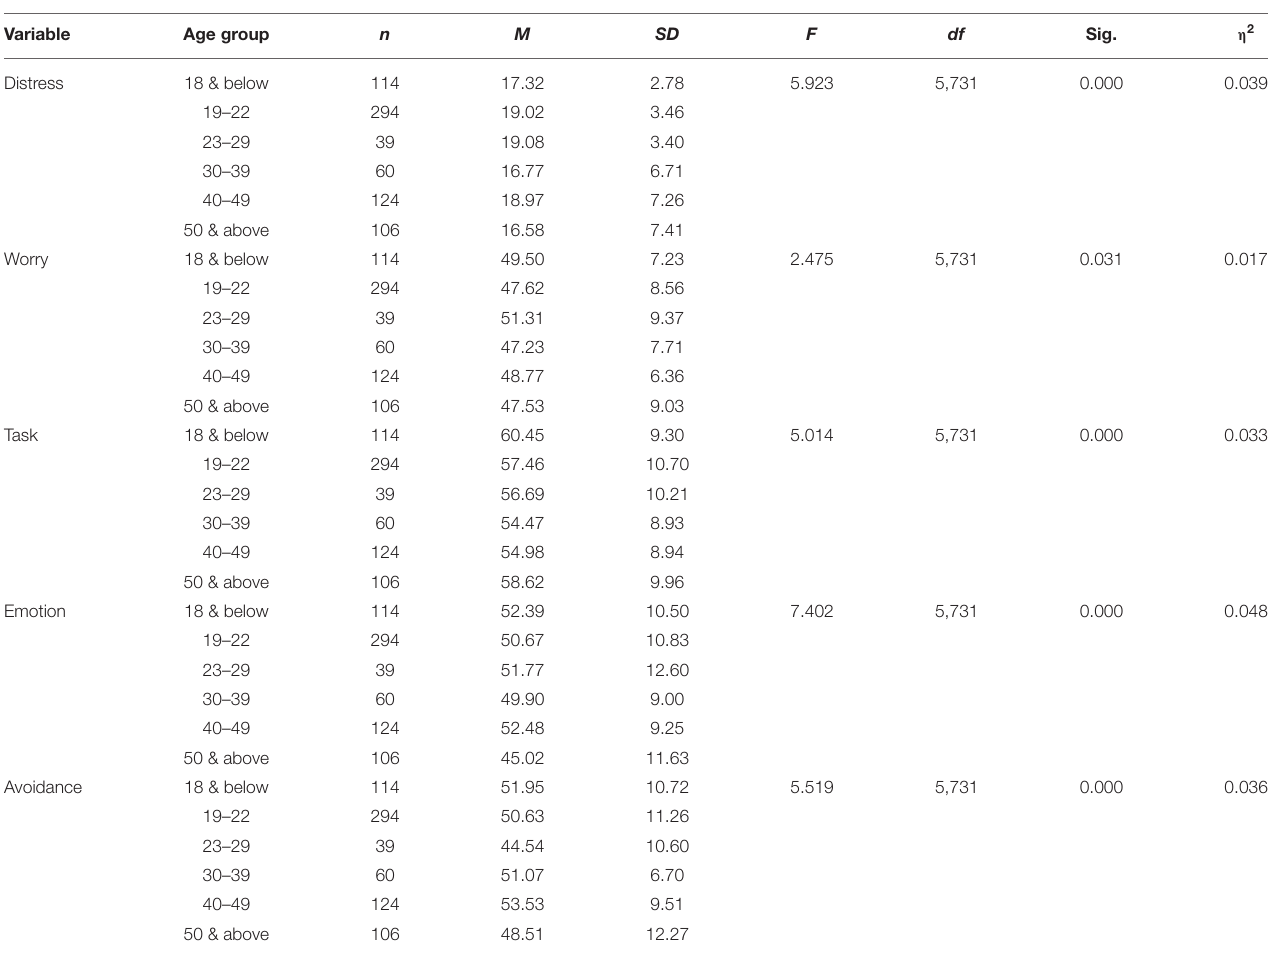
TABLE 7 | ANOVA results of distress, worry, and coping differences across age groups. Variable